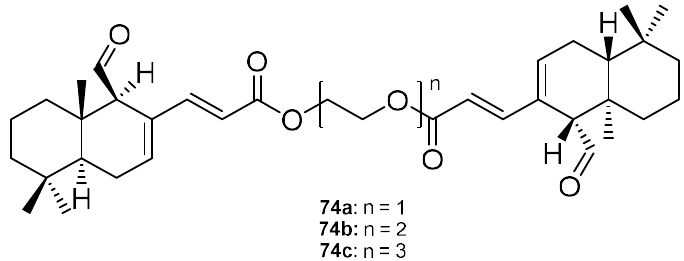
Figure 15. Polyethylene-linked polygodial dimers 74a – c [69].